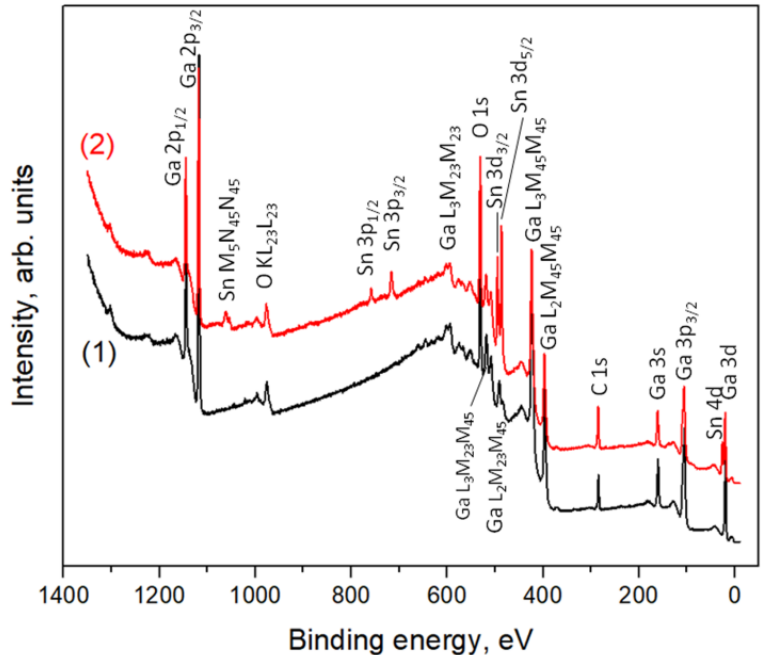
Figure 5. Survey XPS spectra of Ga 2 O 3 (Sn) annealed at 750 °C: ( 1 ) x = 0; ( 2 ) x = 13 at.% Sn. The main photoelectron and Auger lines of gallium and oxygen are identified.